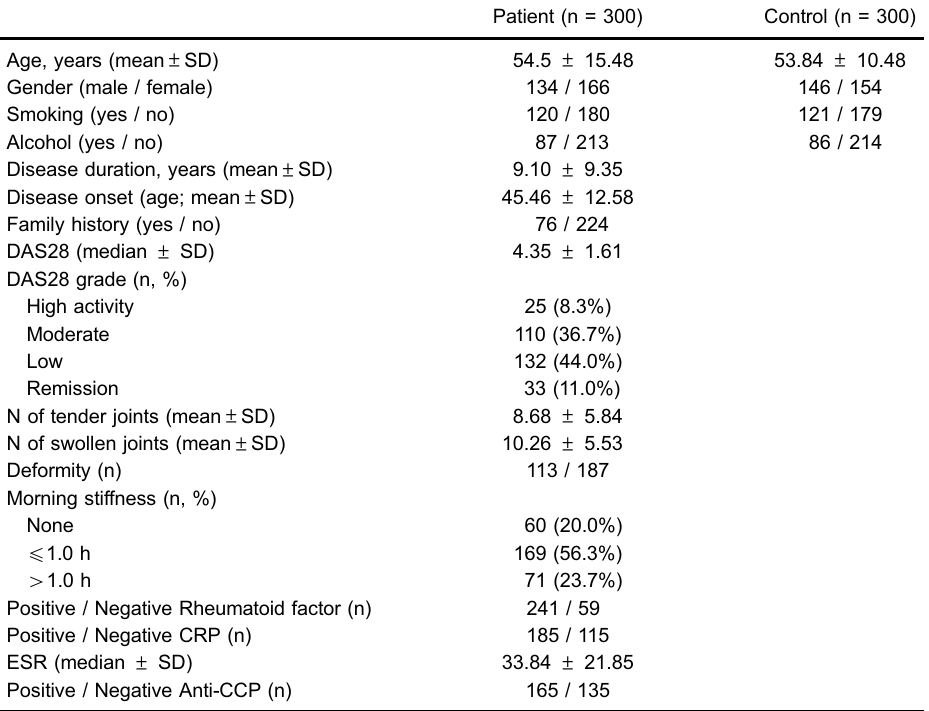
Table 1. Demographics and baseline characteristics of rheumatoid arthritis